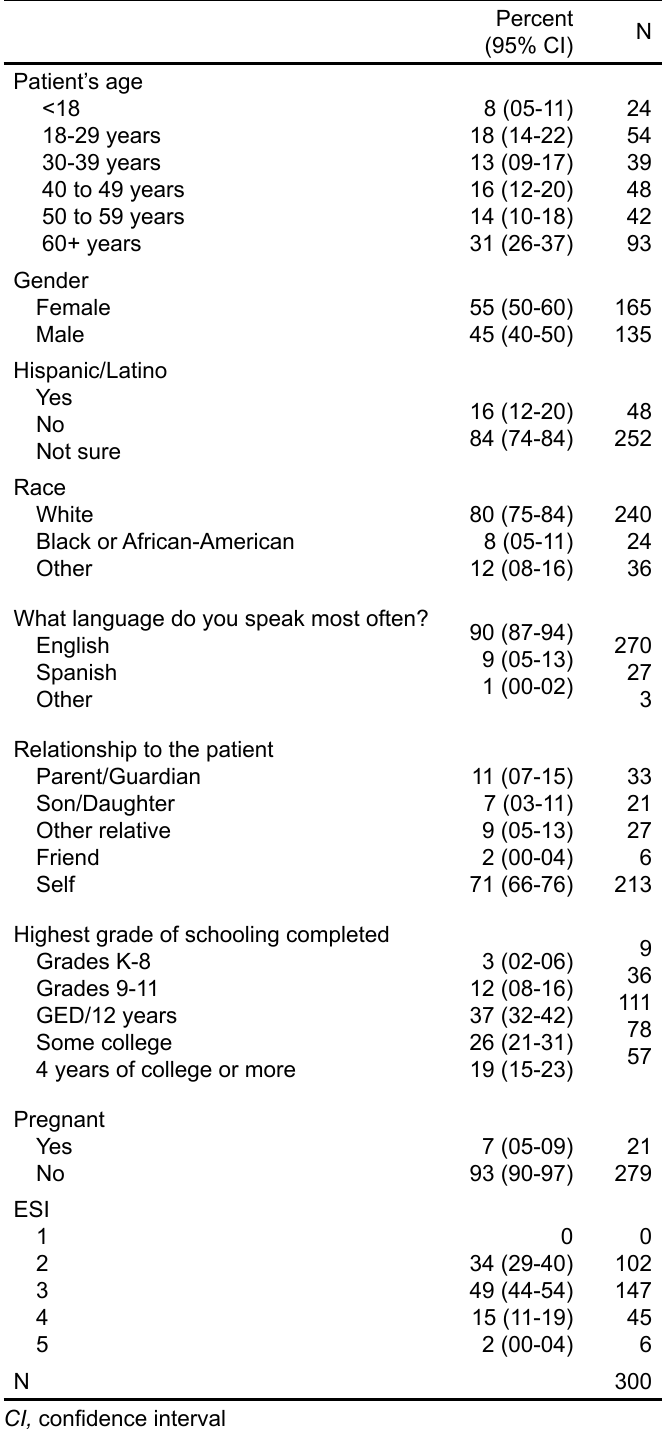
Table 1. Demographics of survey